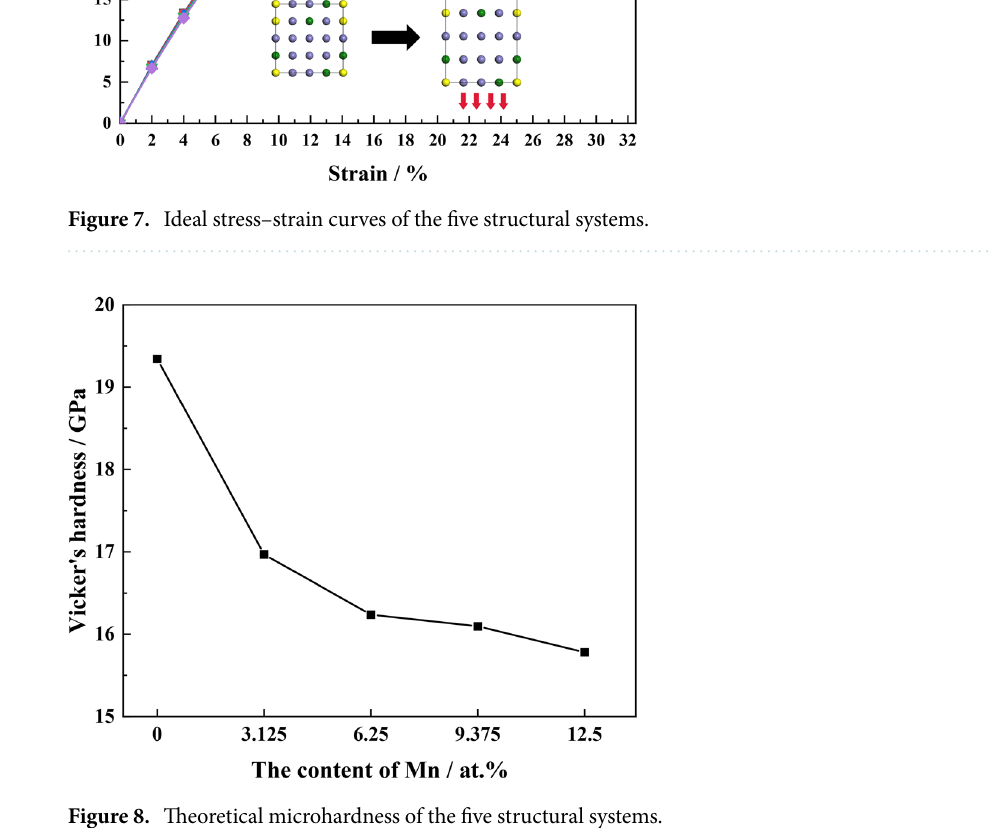
Figure 8. Theoretical microhardness of the five structural systems.